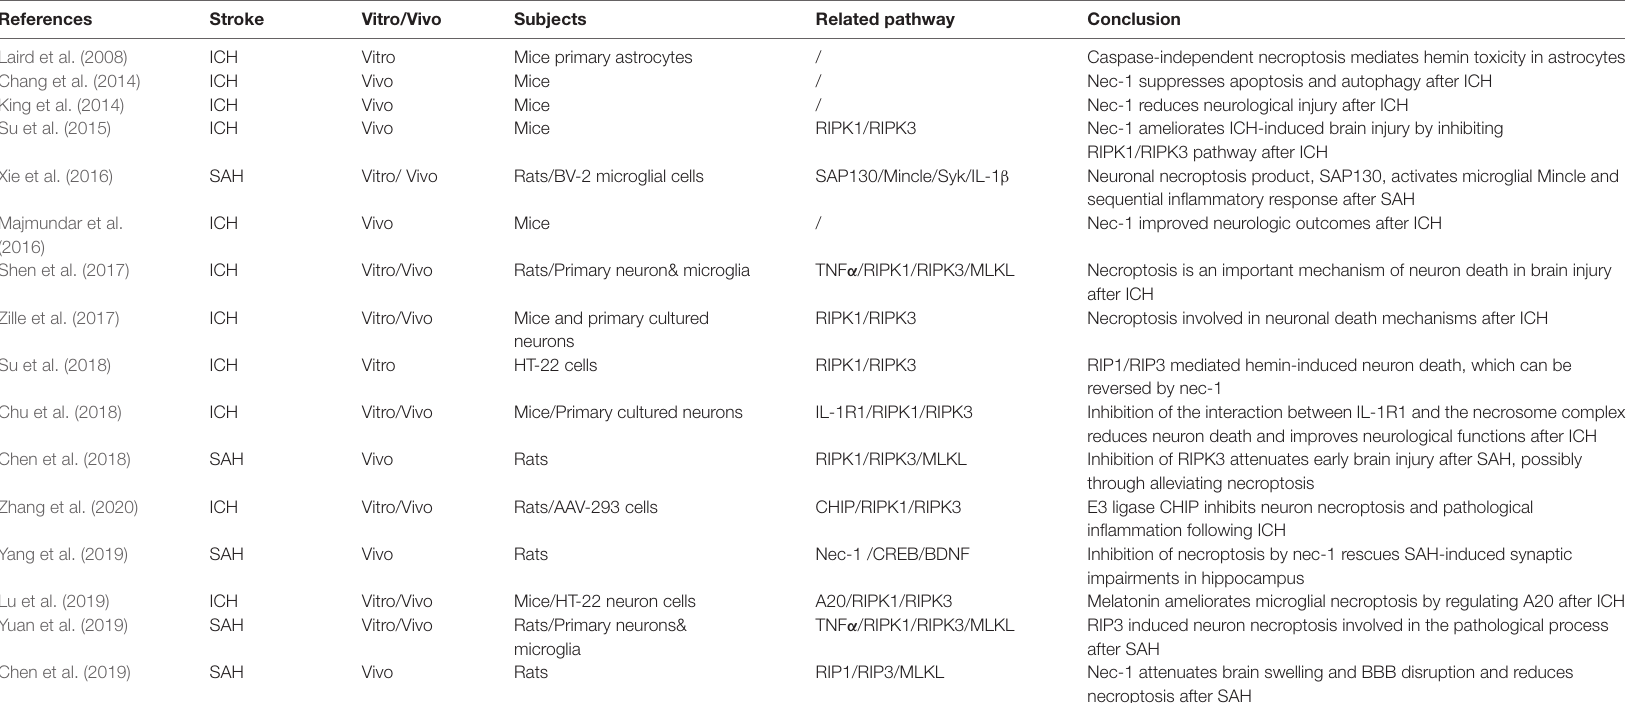
TABLE 1 | Latest research of necroptosis in hemorrhagic